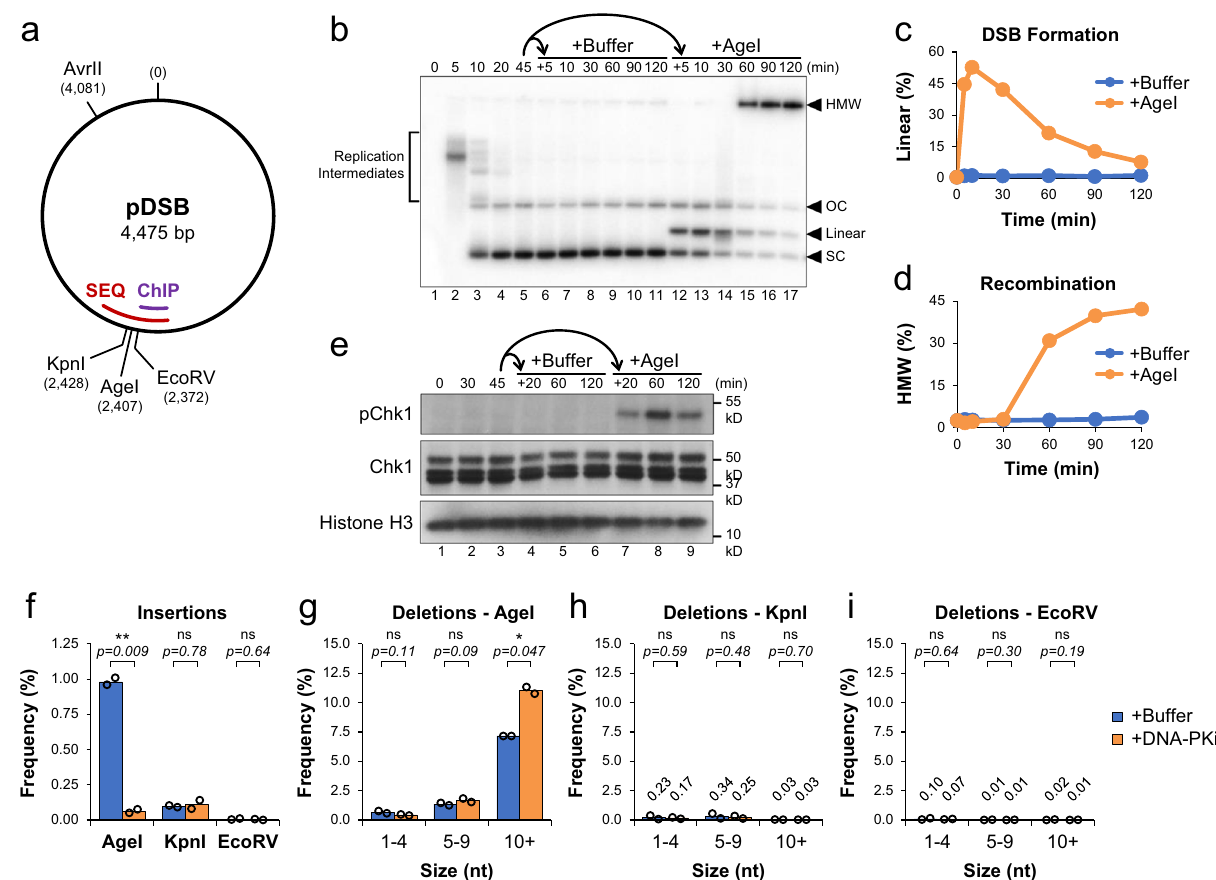
Fig. 1 Competition between DSB repair pathways in Xenopus egg extracts. a Schematic of pDSB showing the relative position of restriction enzyme sites and DSB regions ampli fi ed for ChIP and amplicon sequencing (SEQ). b pDSB was replicated in the presence of α 32 P[dATP] for 45 min. The reaction was then split and supplemented with buffer or AgeI. Samples were withdrawn, resolved by 1D gel electrophoresis, and visualized by autoradiography ( n = 4 independent experiments). Labels indicate the position of: replication intermediates, supercoiled (SC), linear, and open circular (OC) plasmids, and high molecular weight (HMW) molecules. c , d Quantitation of linear ( c ) and HMW ( d ) molecules from ( b ). e Protein samples from ( b ) were withdrawn and analyzed by Western blot (n = 2 independent experiments). f – i pDSB was replicated in extract supplemented with buffer or NU7441 (DNA-PKi)